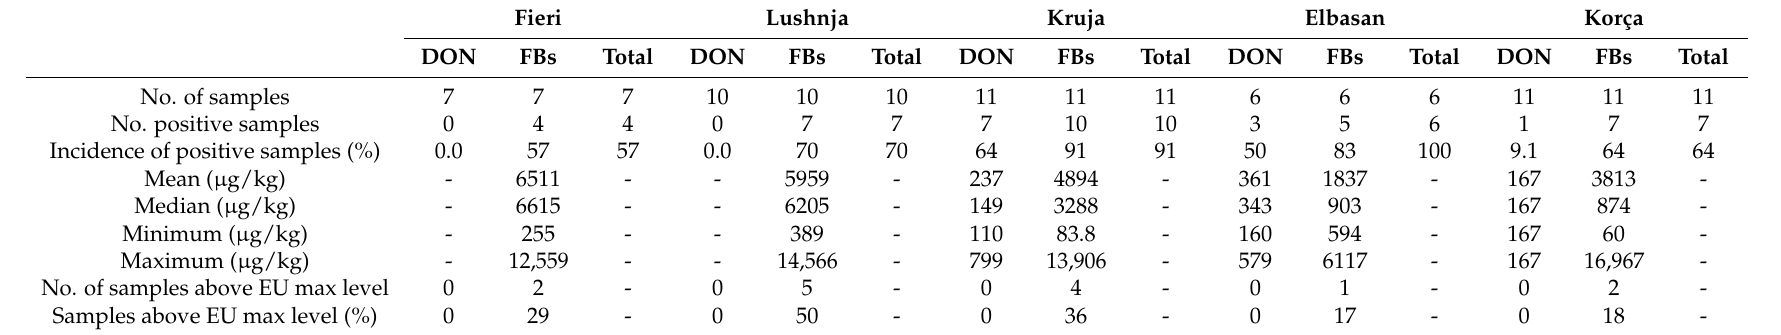
Table 4. Occurrence of DON and FBs (sum of FB1 and FB2) in maize samples from the harvesting seasons 2014 and 2015 for each region. Fieri Lushnja